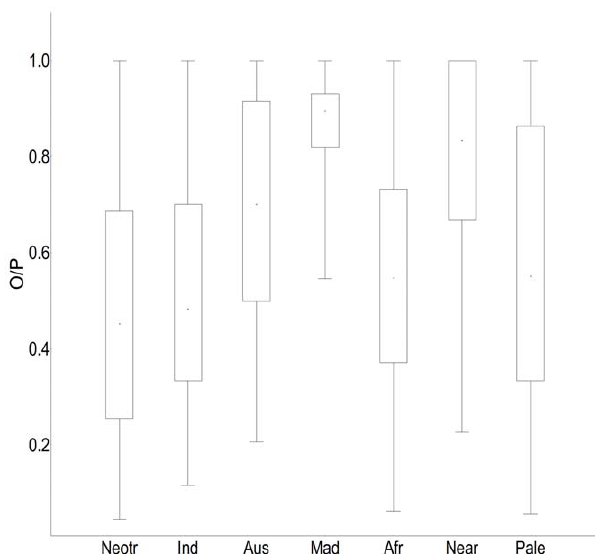
Figure 3. Degree of climatic equilibrium for amphibians within the seven biogeographical regions. Boxes are the percentiles from 25 to 75% around O = P medians, lines indicate the standard deviation.